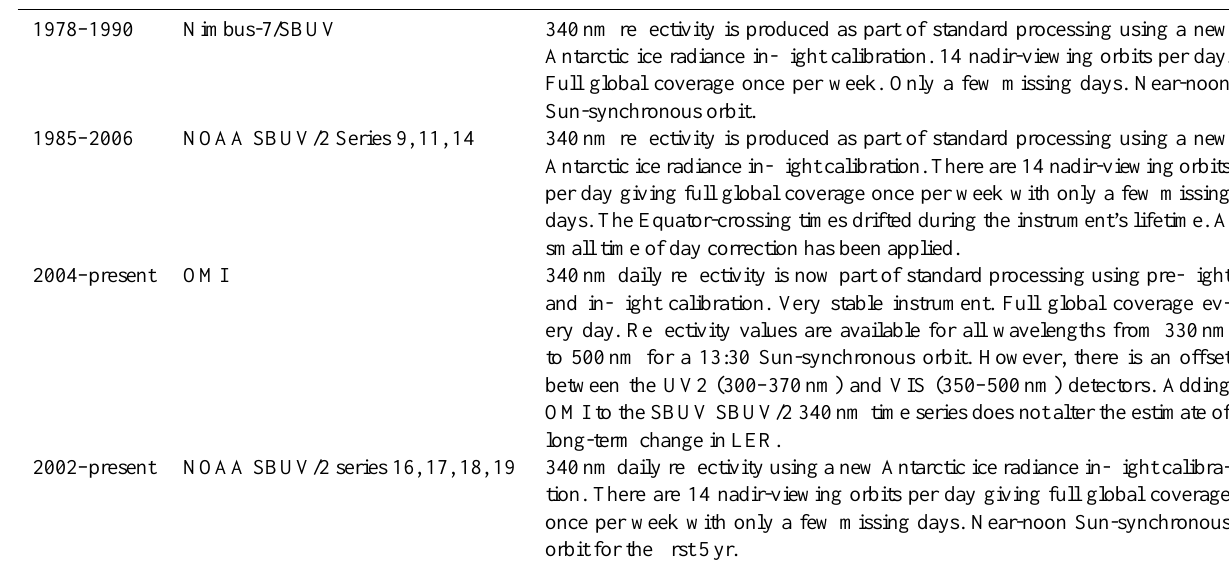
Table 1. UV satellite data sets used for 340nm